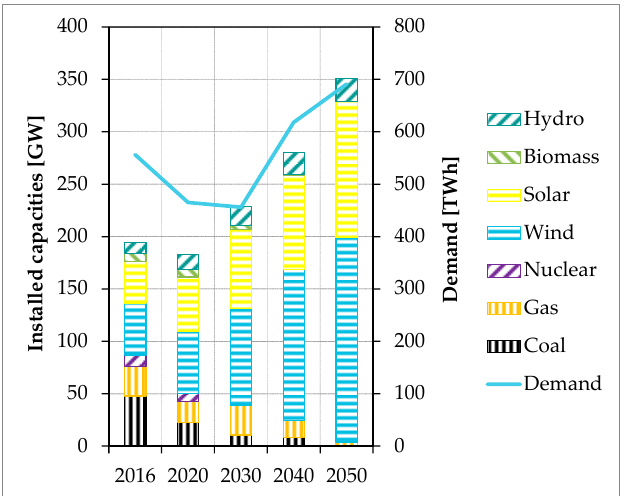
Figure 4. Electricity demand and installed capacities in Germany. Source: References [28,35].